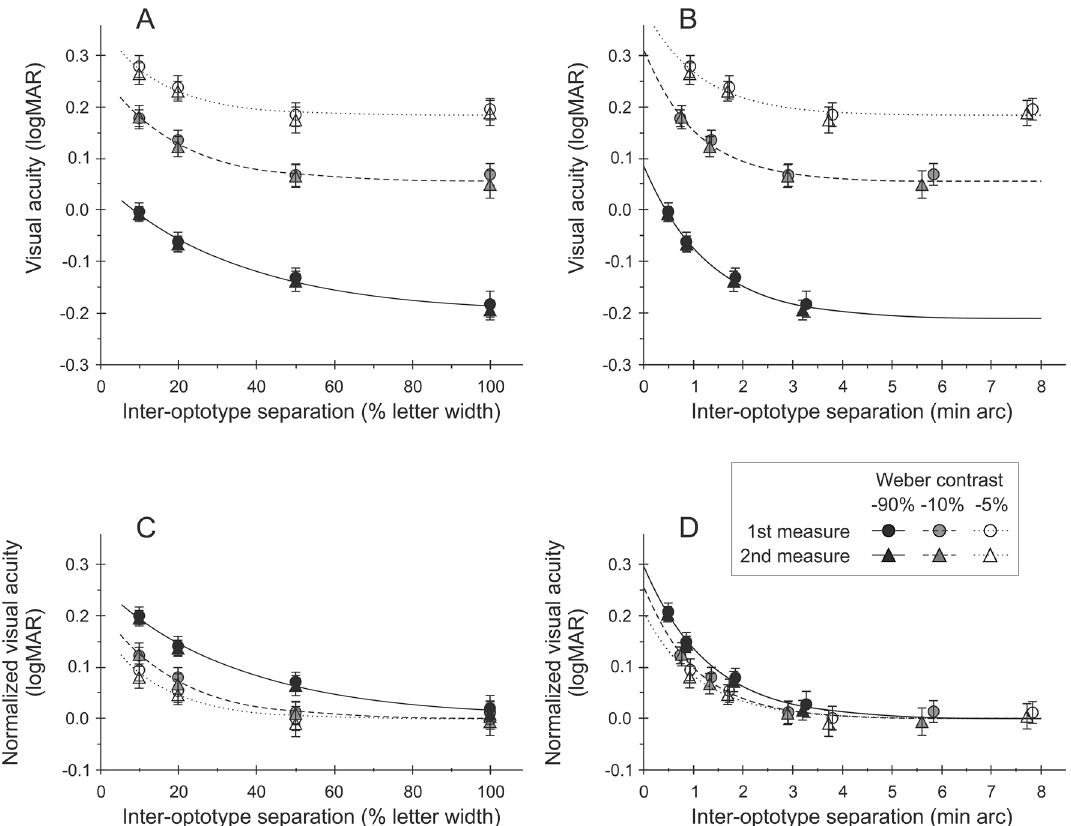
Figure 1. The top left panel ( A ) shows the average logMAR across all subjects, plotted against edge-to-edge inter-optotype separation (% letter width) for high (open symbols), intermediate (grey symbols) and low (closed symbols) contrast levels. Data for test (circles) and re-test (triangles) are shown. The data set for each contrast condition is fitted by an exponential curve. The top right panel ( B ) shows the same data, but this time plotted against inter-optotype separation in min arc. The bottom panels ( C ) and ( D ) plot logMAR acuity, normalized to the asymptotic value of each exponential curve. It is evident in all 4 panels that logMAR increases both as a function of decreased contrast and reduced inter-optotype separation. In the two left panels ( A ) and ( C ), the increase appears less under the intermediate and low contrast conditions. However, this difference is much less evident in the two righthand panels ( B ) and ( D ), in which the letter separation is expressed in min arc. An example showing the results from an individual subject is shown as a Supplementary File.